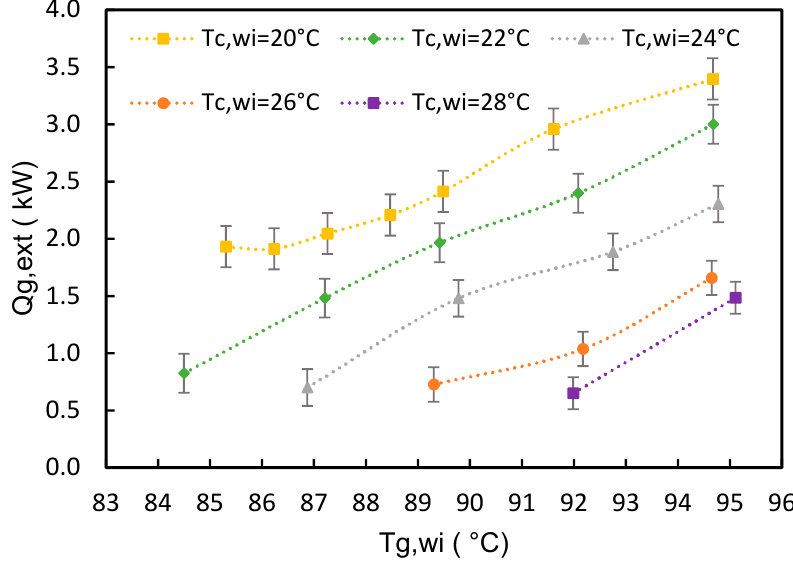
Figure 13. Generation power as a function of the generation temperature.